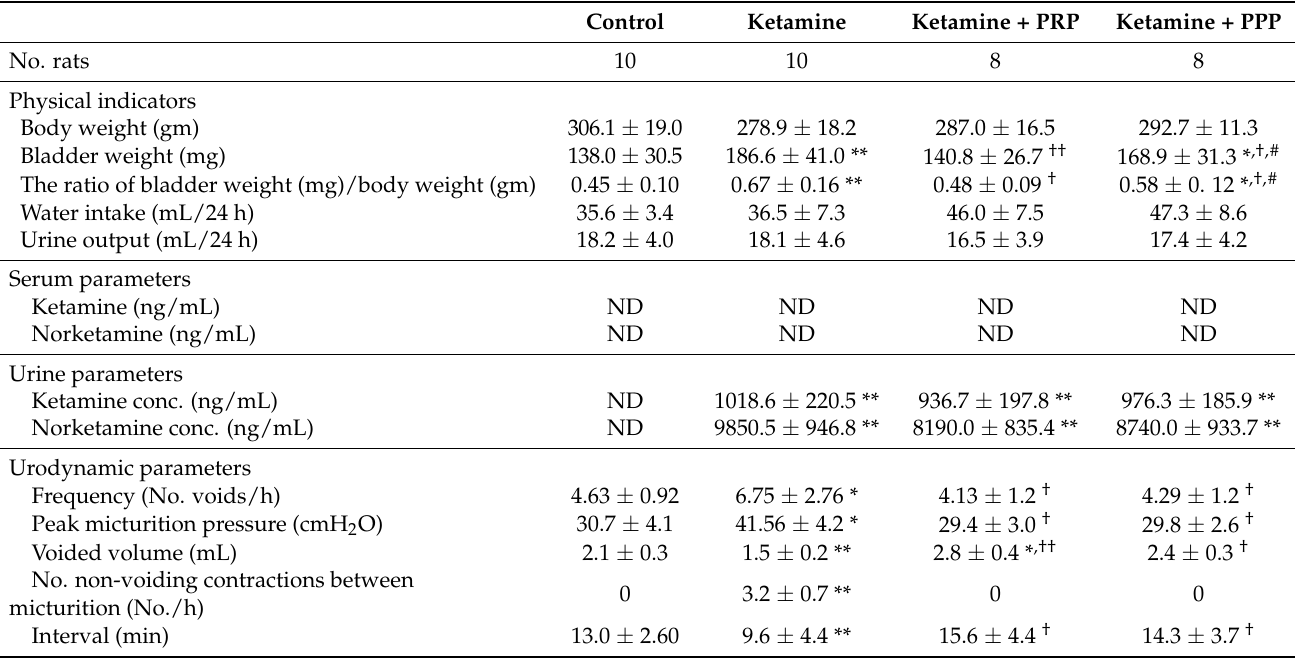
Table 1. Physical indicator, serum, urine and urodynamic for the different experimental group.